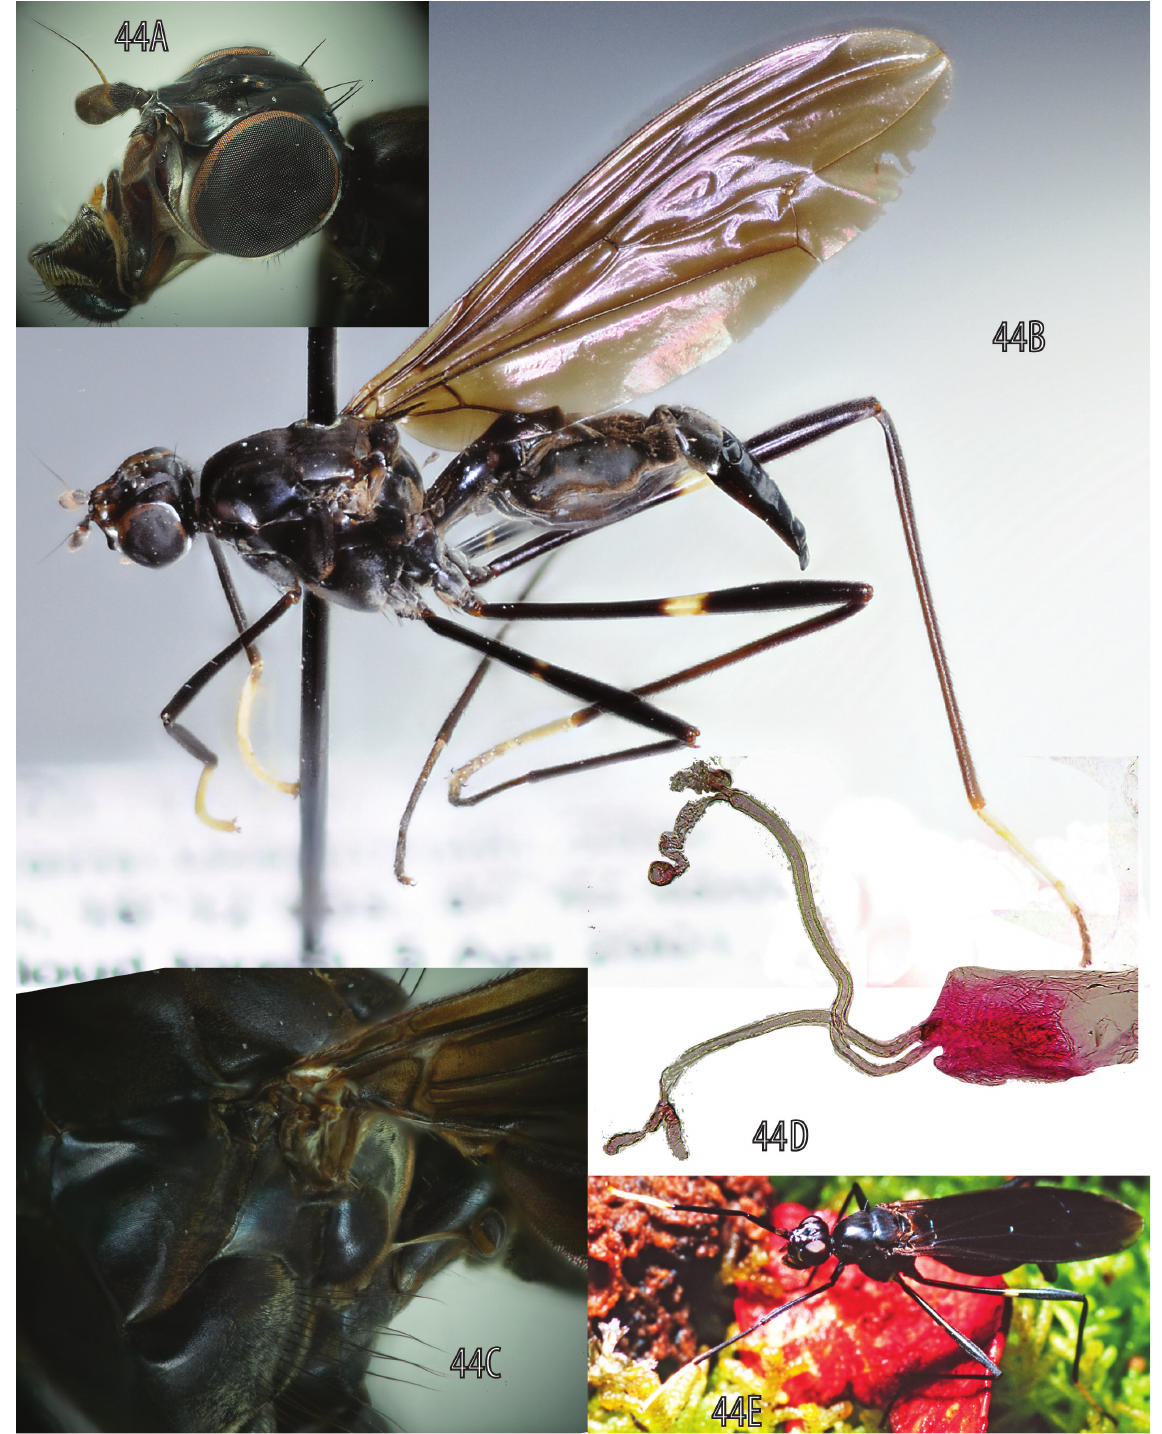
Fig. 44. Mesoconius nigra sp. nov . A . Head, dorsolateral view. B . Holotype, ♀, CBFC. C . Posterior part of thorax, lateral view. D . Spermathecae and associated structures. E . Living